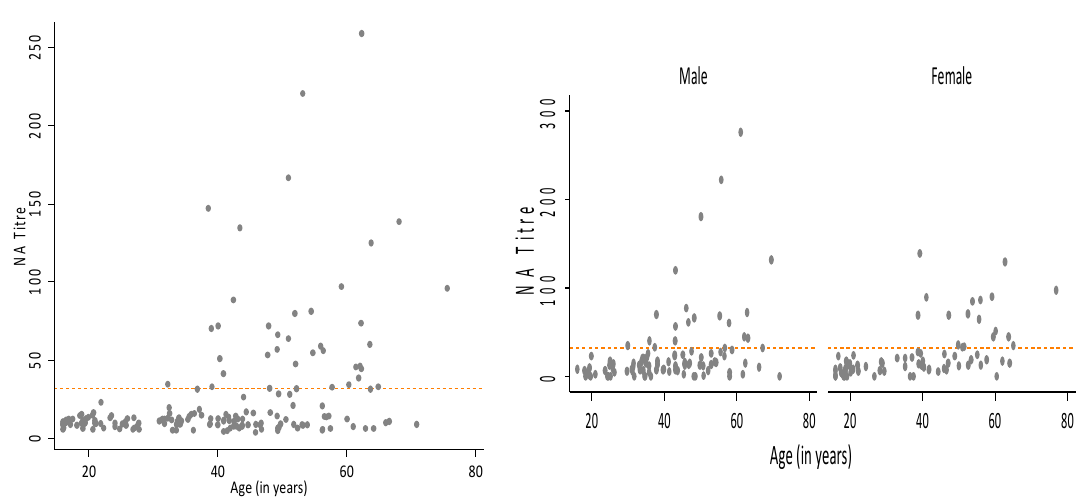
Figure 2. Geometric mean titres with 95% confidence interval (CI) for anti-vaccinia neutralising antibody by age group, including seronegative (horizontal line is the level considered seropositive, >32). Table 1. Geometric mean titres (GMT) for anti-vaccinia neutralising antibody by age group for the total sample and restricted to the people considered seropositive (titre ≥ 32), with 95% confidence interval (CI). Age (Years)